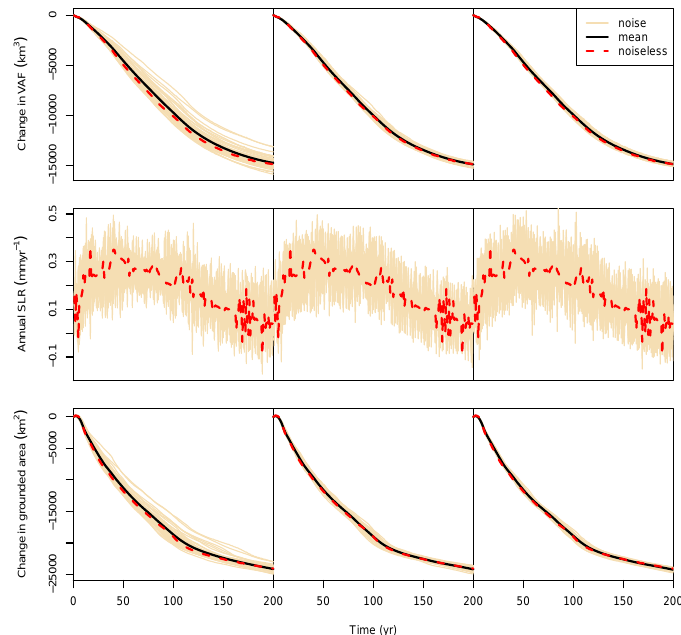
Figure 12. Change in ice volume above floatation (VAF) over the Aurora-Basin–Totten-Glacier region (Figs. 1 and 2c), annual sea level rise (SLR) and change in grounded area. The three columns are for experiments with lower- (left), medium- (middle) and higher- (right) frequency noise on the bedrock. The lower-frequency noise results in more variation in the change in both VAF and grounded area than the higher-frequency noise, while the noiseless results are close to the ensemble mean in each